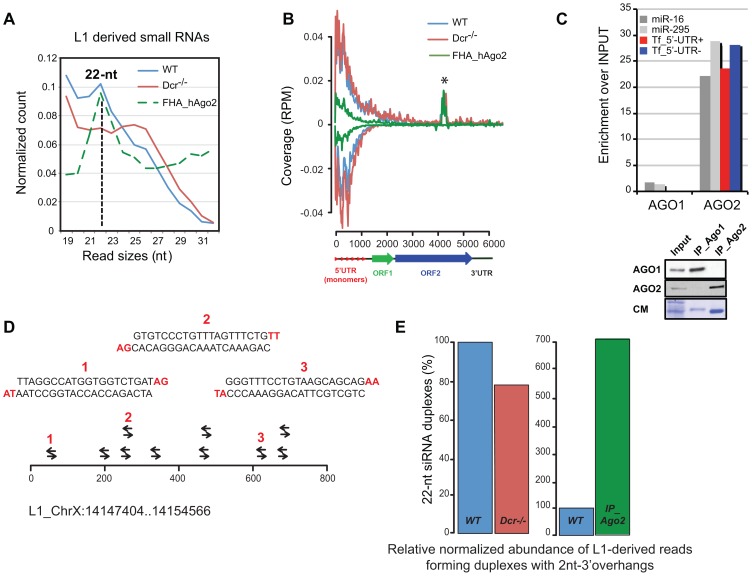
L1 sRNAs are partially produced by DCR and 22-nt L1-sRNAs loaded into AGO2.A. Size distribution of sequencing reads mapping to L1_Tf elements in Dcr
−/− compared to WT mESCs. Note the deficit in 21–23-nt sRNAs in the former, and their enrichment in immunoprecipitated FHA-hAgo2, used in (B). B. Sequence coverages of L1_Tf elements from WT, Dcr
−/− and immunoprecipitated E14-FHA-hAgo2 mESCs, as in Figure 1A. * this peak is an artefact found in all libraries sequenced. C. qRT-PCR analysis of the most abundant sense and antisense L1_5′-UTR-derived sRNAs and of two mESC miRNAs in immunoprecipitates of endogenous AGO1 and AGO2. Lower panel: control Western analysis of endogenous AGO1 and AGO2 levels after immunoprecipitation; CM: Coomassie staining of total protein. D. Snapshot representation of perfect, 22-nt-long sRNA duplexes with 2-nt 3′ overhangs (in red) mapped on the 5′-UTR of a single L1-Tf element located on chromosome X. E. Relative proportions of all L1-Tf-derived sequences forming perfect duplexes with 2-nt overhangs in WT versus Dcr−/− mESCs (left panel) and their enrichment in AGO2 immunoprecipitates (right panel). The numbers of 22-nt distinct sequences were normalized by the L1-Tf family coverage of RPM and expressed as proportion compare to WT.